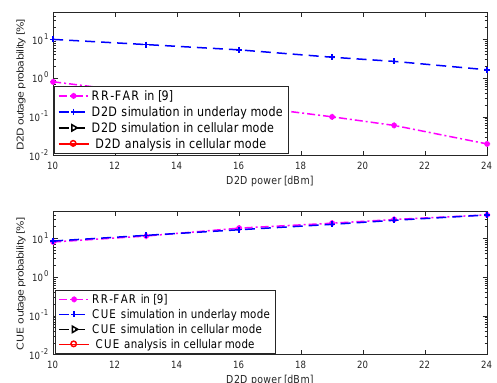
Fig. 4: D2D and CUE outage probability as function of the D2D transmission powers in underlay mode scheme) and cellular mode ( CELLM